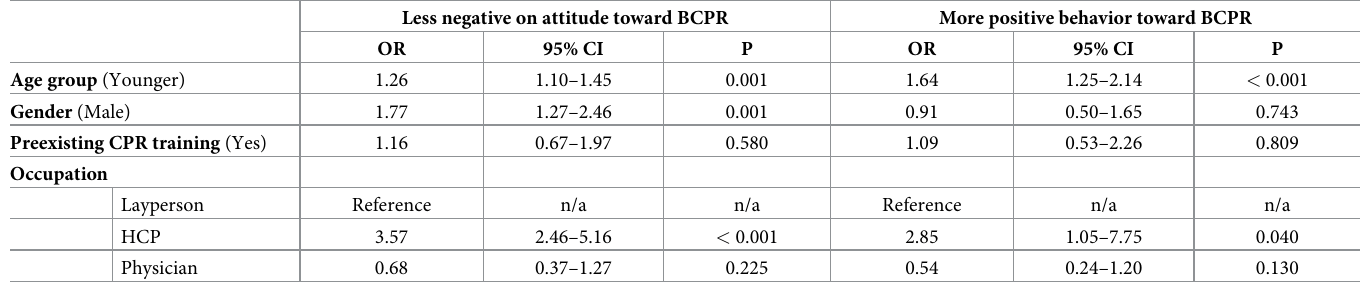
Table 5. Multivariate association between survey predictors and willingness toward